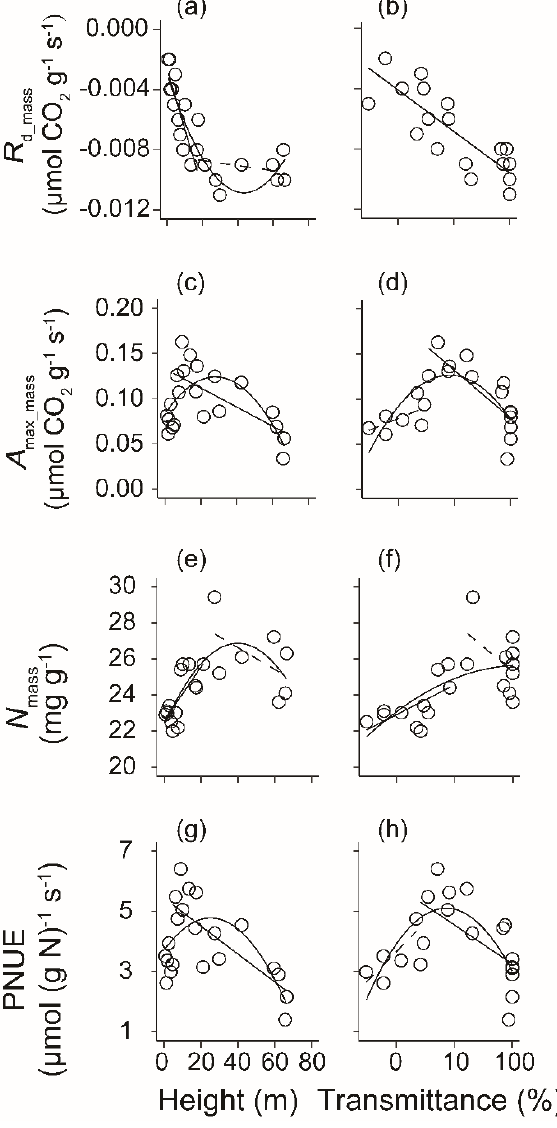
Figure 8. Mass-based physiological traits such as R d_mass , A max_mass , N mass , and photosynthetic nitrogen use efficiency (PNUE) plotted against tree height ( a , c , e , g ) and light (represented as ln(%TRANS)) ( b , d , f , h ). Lines indicate the linear piecewise regression results; solid lines denote significant relationships ( P < 0.05), and broken lines denote nonsignificant relationships. The curve indicates the quadratic regression result. Note that a natural log scale is used on the X-axis in panels ( b , d , f ) and ( h ).